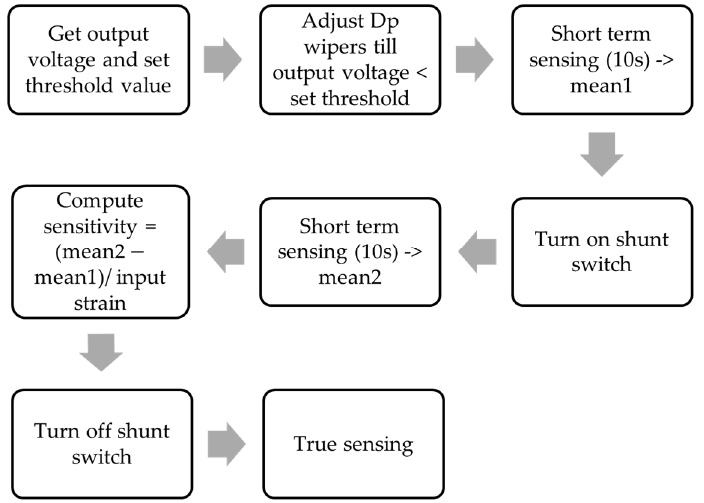
Figure 4. Diagram of software implemented autobalancing and shunt calibration process.